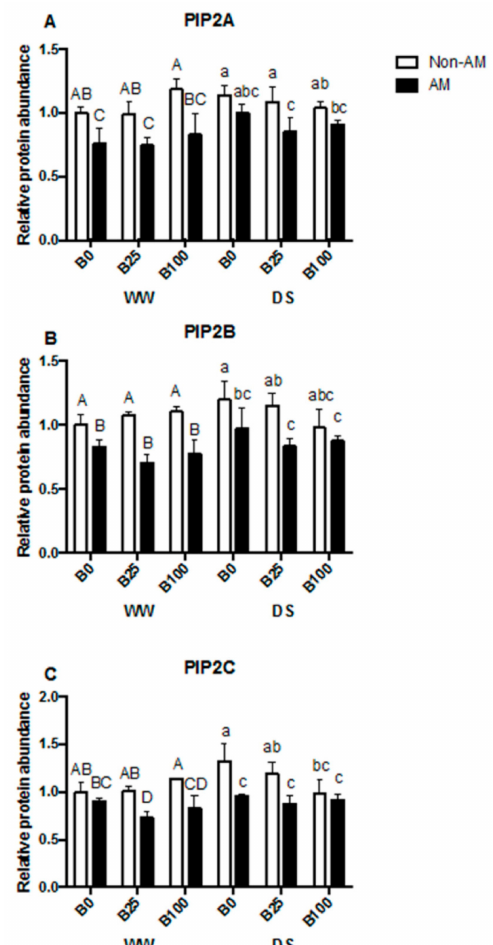
Figure 7. ( A ) PIP2A (Ph-Ser280), ( B ) PIP2B (Ph-Ser283) and ( C ) PIP2C (PhSer280 / Ser283) relative protein abundance in the microsomal fraction of roots from plants inoculated or not with the AM fungus R. irregularis , grown under di ff erent B concentrations (0, 25 or 100 µ M B) and submitted to two water regimes (well-watered [WW] or drought stress [DS]). Data indicate the mean ± SE for three biological replicates. Di ff erent letters indicate significant di ff erences between treatments ( p < 0.05) based on Duncan’s